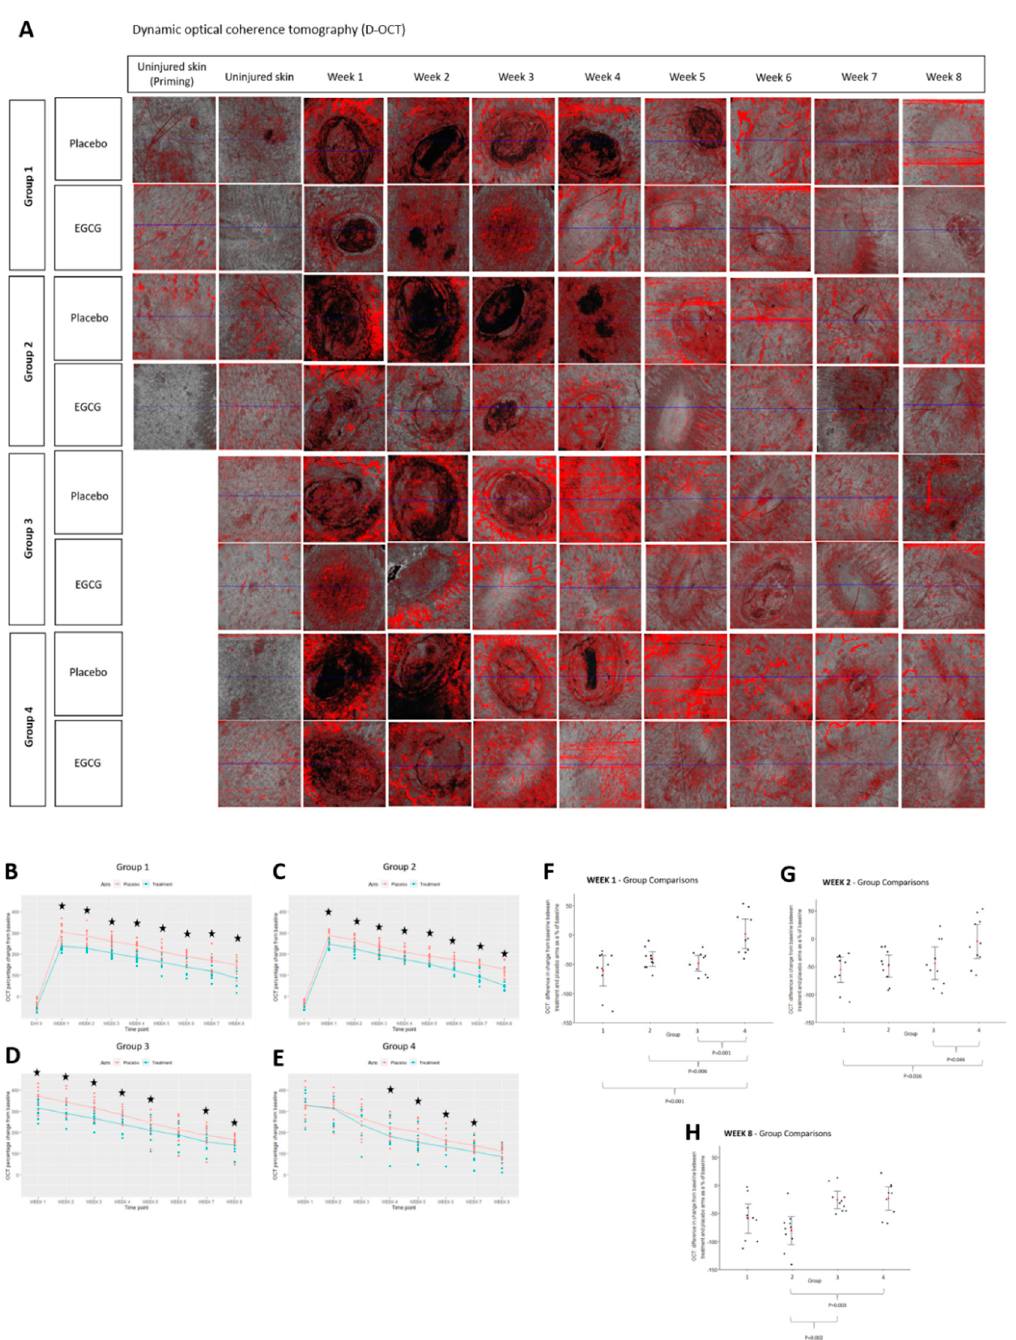
Figure 14. Clinical analysis of blood flow using non-invasive objective device; dynamic-optical coherence tomography (D-OCT). ( A ) D-OCT images of EGCG arms compared to placebo. ( B ) Group 1 D-OCT measurements. ( C ) Group 2 D-OCT measurements. ( D ) Group 3 D-OCT measurements. ( E ) Group 4 D-OCT measurements. ( F ) Group comparison analysis for D-OCT at week 1. ( G ) Group comparison analysis for D-OCT at week 2. ( H ) Group comparison analysis for D-OCT at week 8. Significance: ★ p ≤ 0.01.